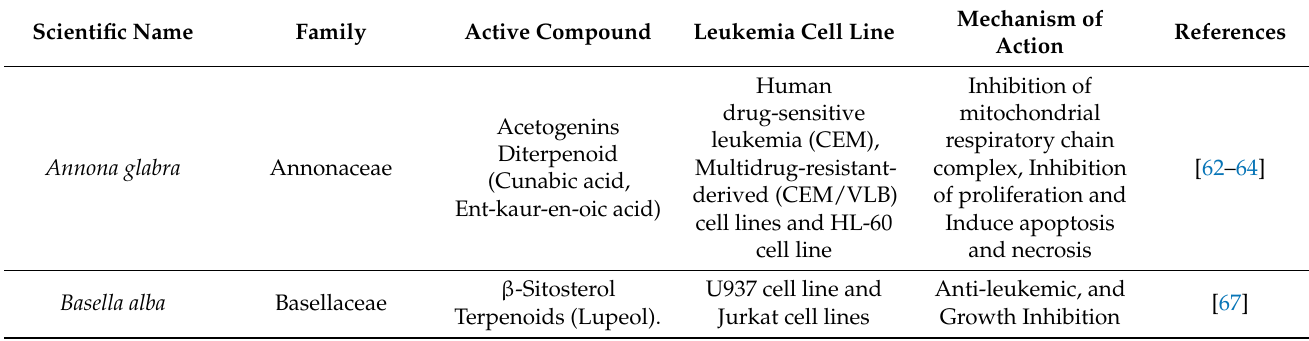
Table 1. A list of traditionally used medicinal plants demonstrating cytotoxic effects in different leukemia cell lines. Scientific